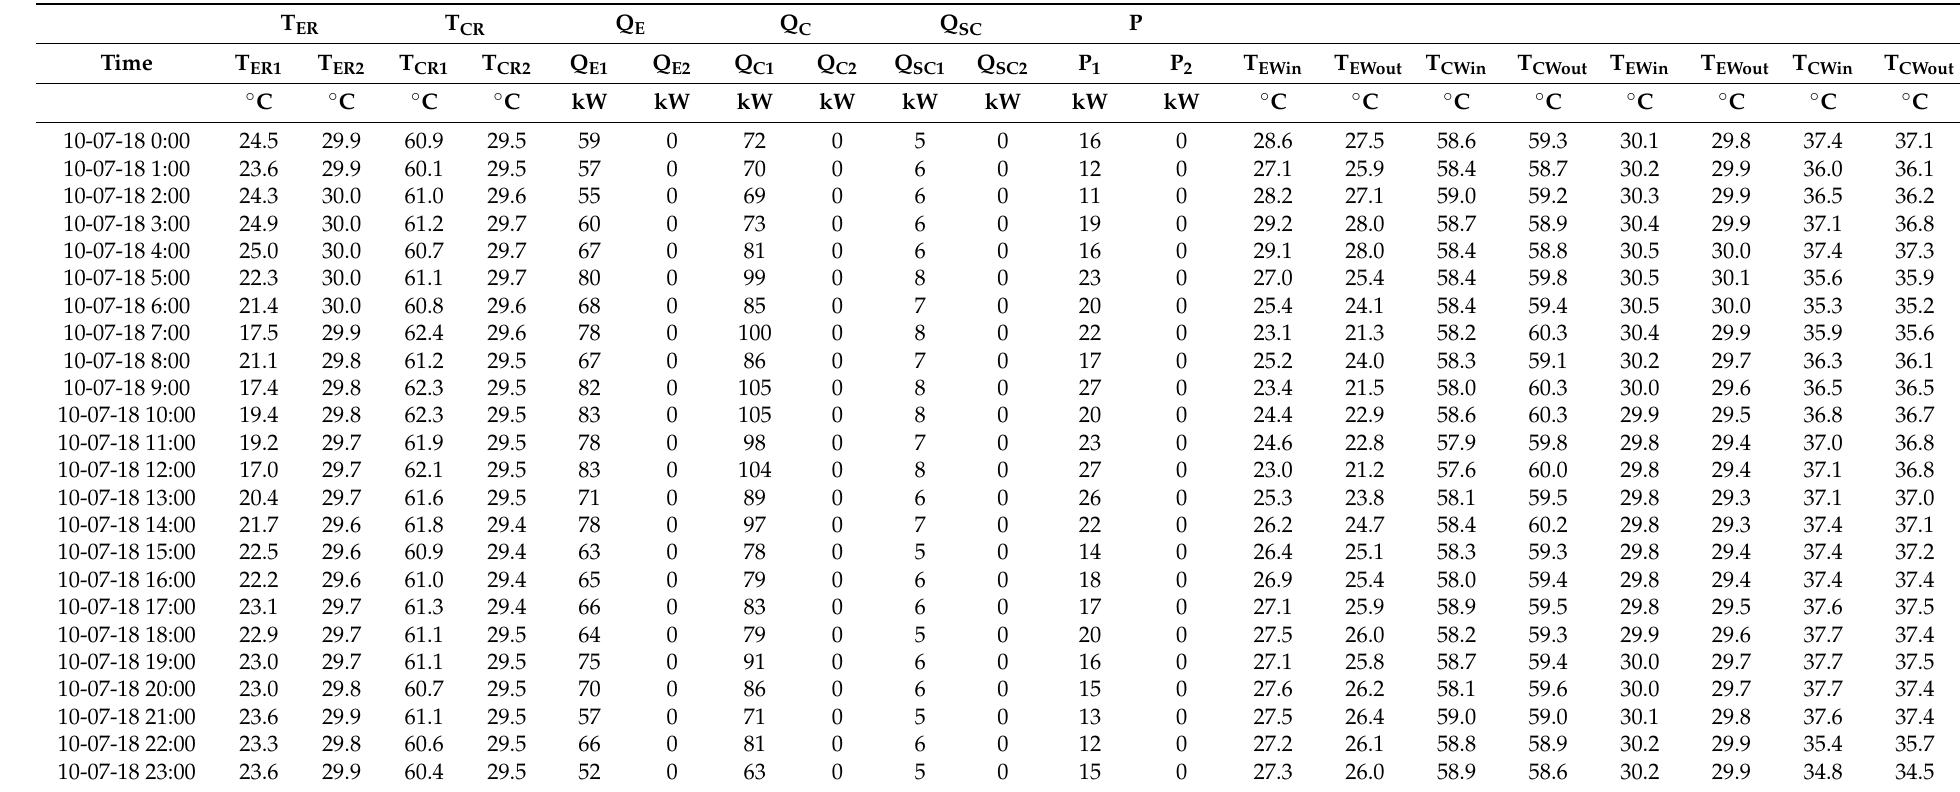
Table A6. Sample data from HP3 for a typical summer